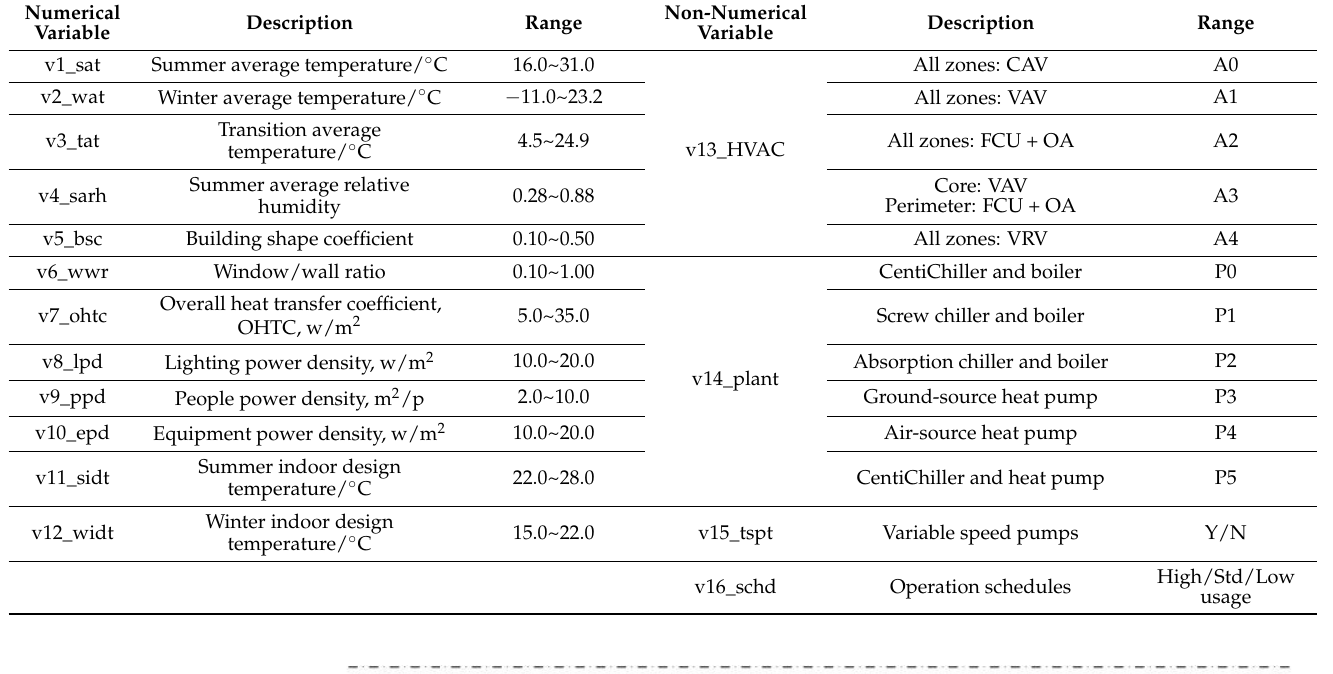
Table 2. The 16-D variables covered by the office BPD.